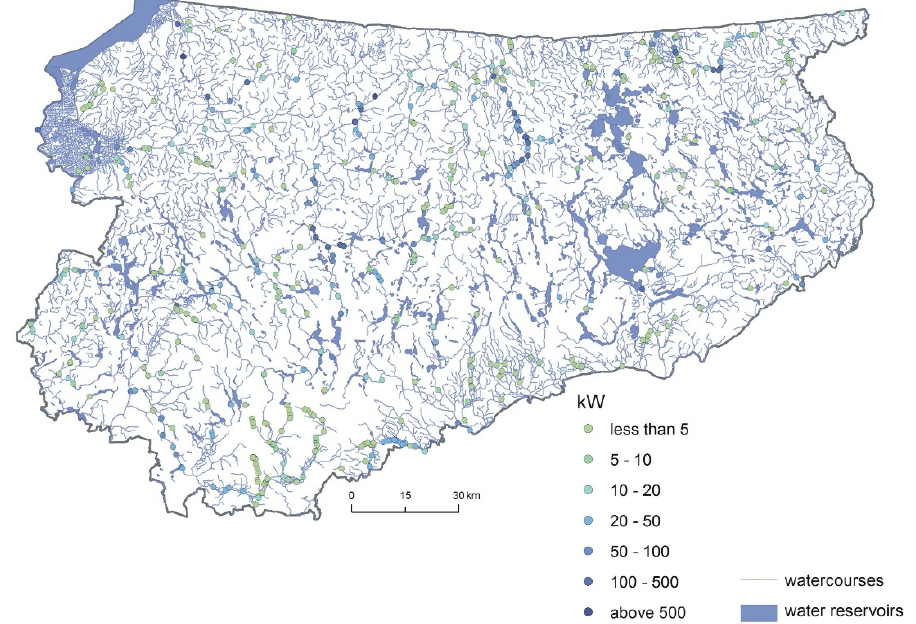
Figure 19. Localization of water dams and power of the potential hydropower plants in the Warmi ń sko-Mazurskie voivodeship (own elaboration). The power of all the potential hydropower plants in the Wielkoposkie voivodeship on dams is 35.1 MW (Figure